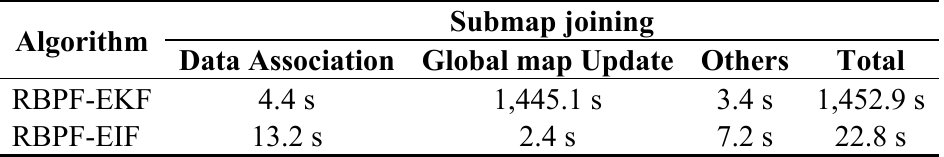
Table 1. The detailed CPU time by using algorithms of RBPF-EKF and RBPF-EIF.